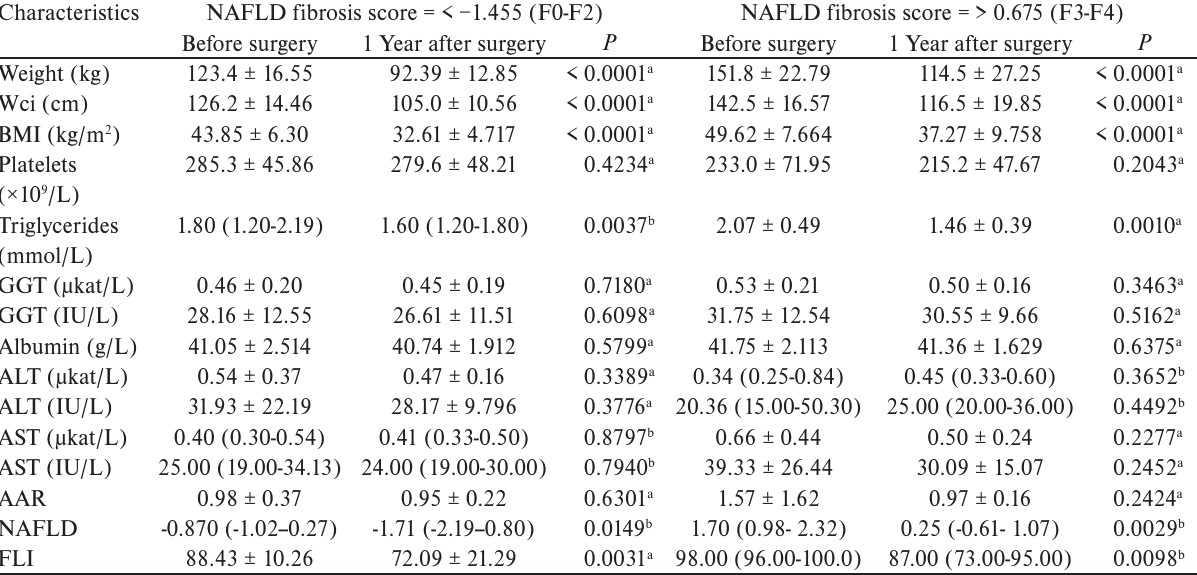
Table 3. Paired value analysis of changes in clinical and biochemical characteristics of morbidly obese patients before and 1 year after bariatric surgery in the cohorts of NAFLD liver fibrosis patients. Characteristics